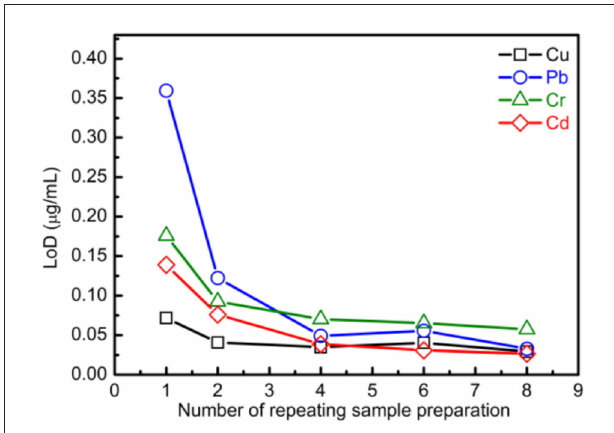
FIGURE 6 | Evolution trends of LoDs for analytical lines (Cu I 324.75nm, Pb I 405.78nm, Cd I 508.58nm, and Cr I 520.84nm) on the number of repeating sample